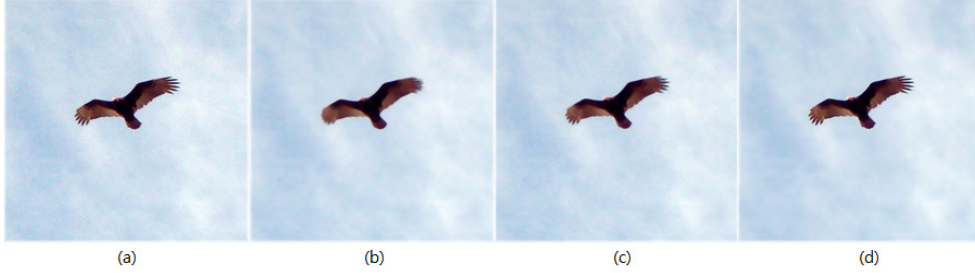
Figure 1. Comparison of reconstructed images: ( a ) original image with noise, ( b ) low-pass filtered image, ( c ) reconstructed image using VDSR [20], and ( d ) reconstructed image using DIP.